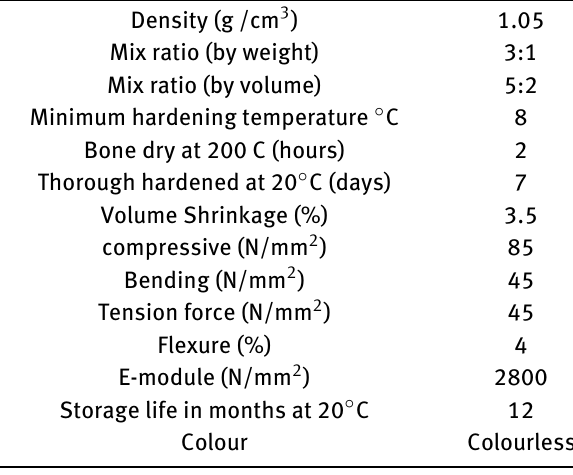
Table 3: The characteristics of